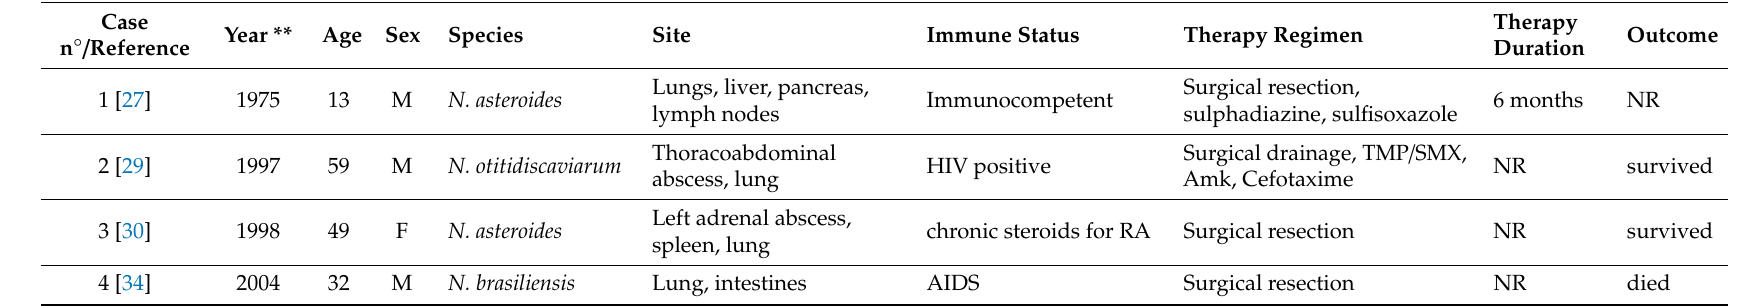
Table 3. Previously published cases of disseminated nocardiosis with abdominal / retroperitoneal